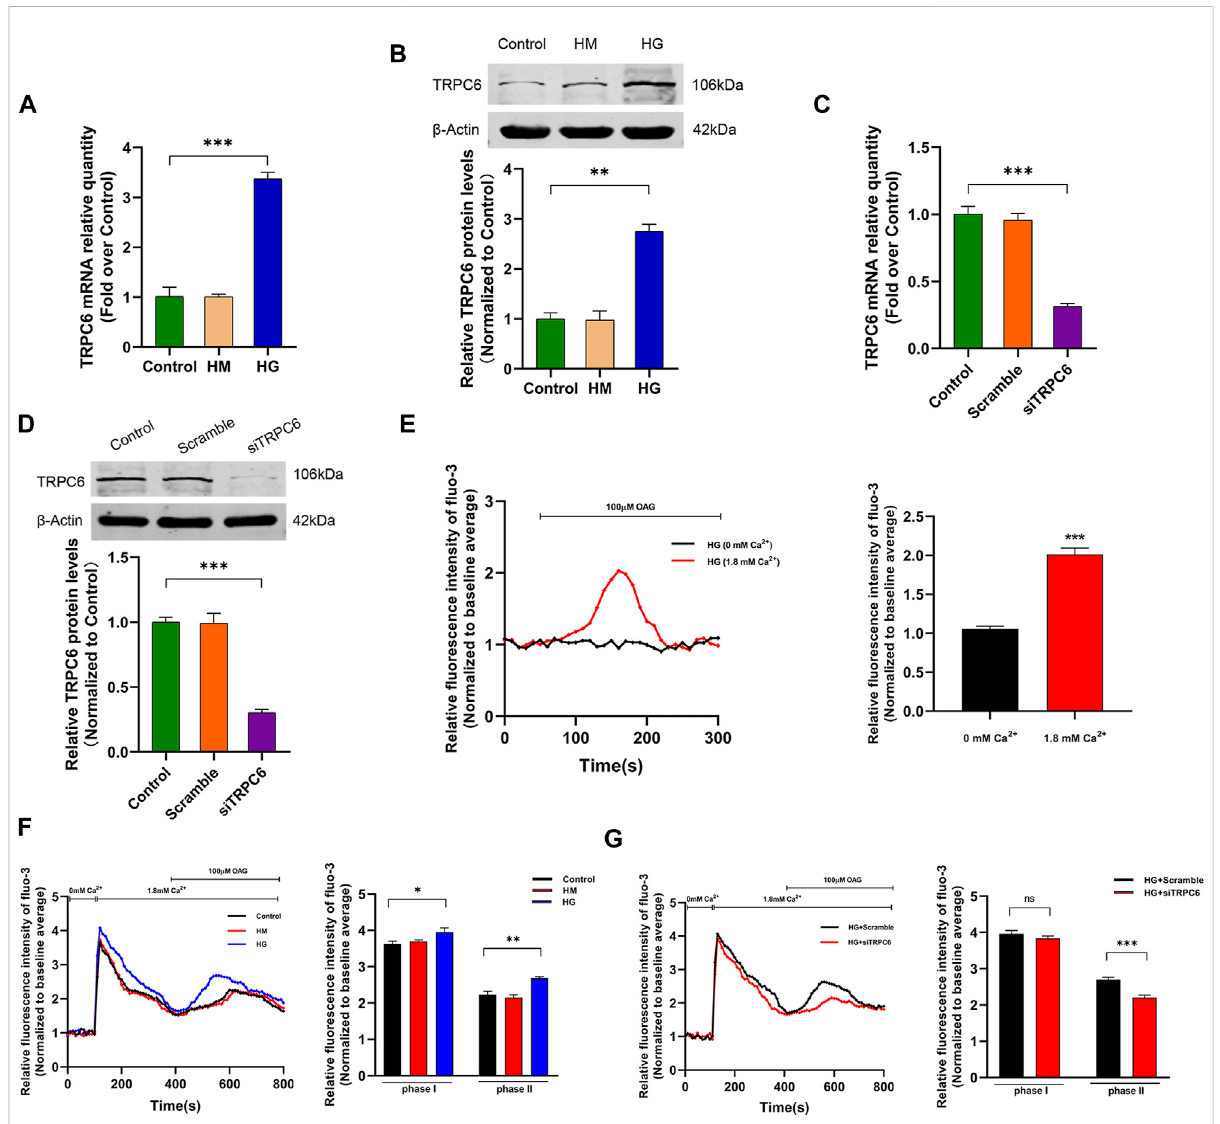
FIGURE 1 Effects ofHG treatment onTRPC6 expression and TRPC6-dependentCa 2+ in fl ux. (A) The mRNA expression levels ofTRPC6 inthecontrol,HM, and HG groups ( n = 3 independent experiments). (B) Representative Western blot and quantitation analysis of TRPC6 in the control, HM, and HG groups( n =3independentexperiments). (C) ThemRNAexpressionlevelsofTRPC6inthecontrol,scramble,andsiTRPC6groups( n =3independent experiments). (D) Representative Western blot and quantitation analysis of TRPC6 in the control, scramble, and siTRPC6 groups ( n = 3 independent experiments). (E – G) Confocal microscopy using Fluo-3 fl uorescence methods was used to observe changes in the intracellular Ca 2+ concentration. (E) Representativetraces(left)andsummarydata(right)oftheOAG-inducedintracellularCa 2+ changesintheHG-treatedpodocytes, incubated with or without 1.8 mM Ca 2+ ( n = 3 independentexperiments). (F) Representative traces (left) and summary data (right) ofthe TG-induced SOCE(phase Ⅰ )andOAG-inducedROCE(phase Ⅱ )inthecontrol,HM,andHGgroups( n =3independentexperiments). (G) Representativetraces(left) and summary data (right) of the TG-induced SOCE (phase Ⅰ )and OAG-induced ROCE (phase Ⅱ )in the HG + scramble and HG + siTRPC6 groups ( n